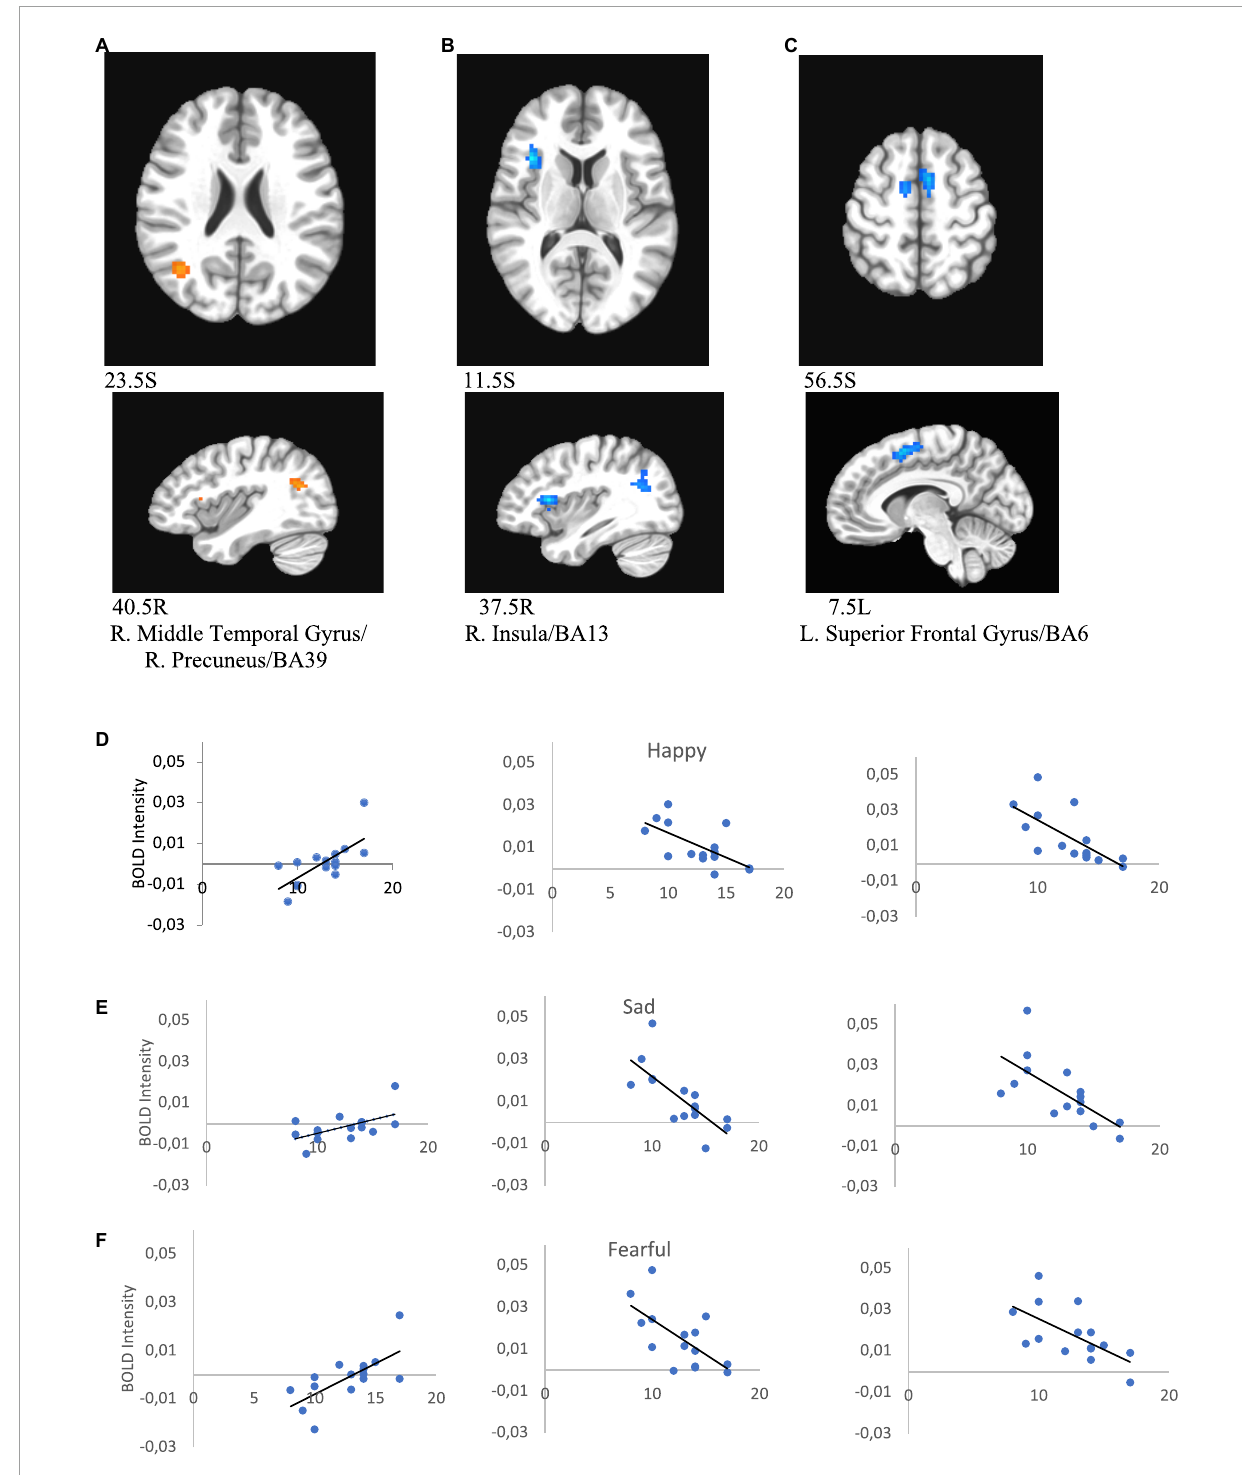
FIGURE9 Brain regions that showed significant melancholic score effect in female MDD participants [ (A) right middle temporal gyrus/right precuneus/BA39; (B) right insula/BA13; (C) left superior frontal gyrus/BA6). Correlations of melancholic scores with BOLD intensity during in panels (A–C) regions for happy (D) , sad (E) , and fearful faces (F) ( p < 0.005).